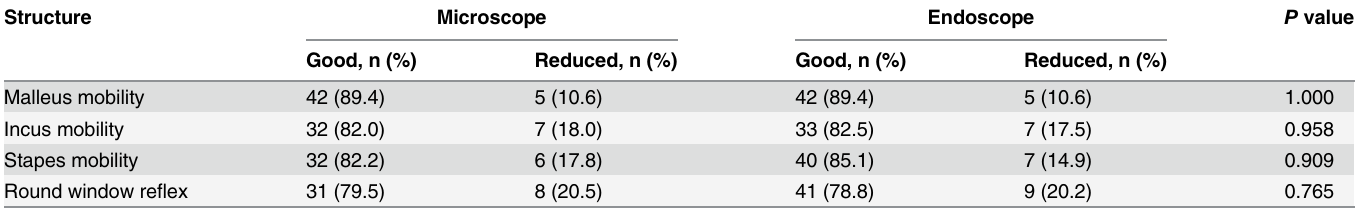
Table 2. The ossicular chain mobility and reflexes of the round window in the microscopic and endoscopic views.